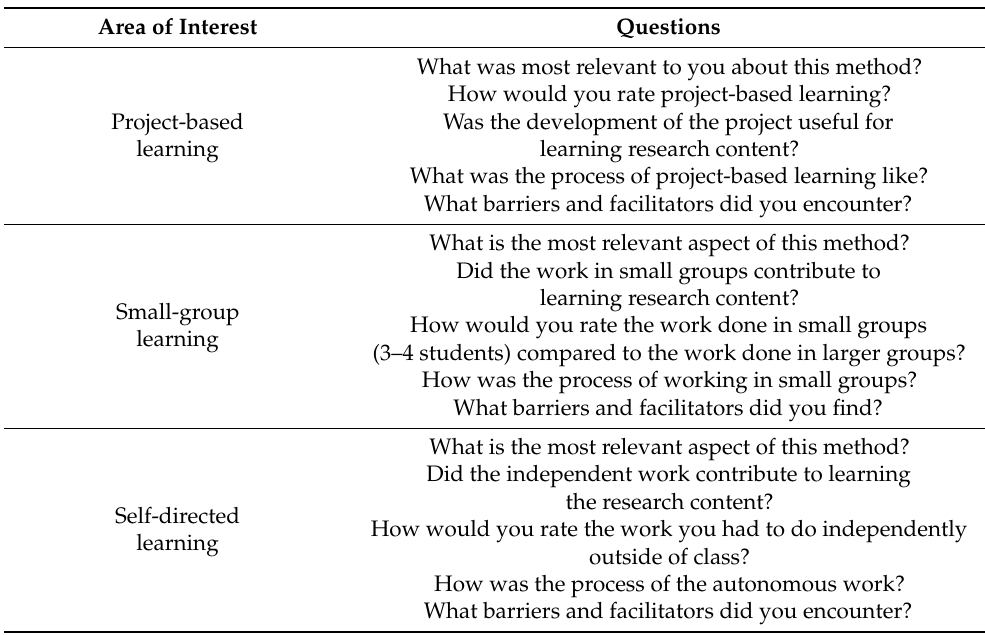
Table 1. Opening and reflexive